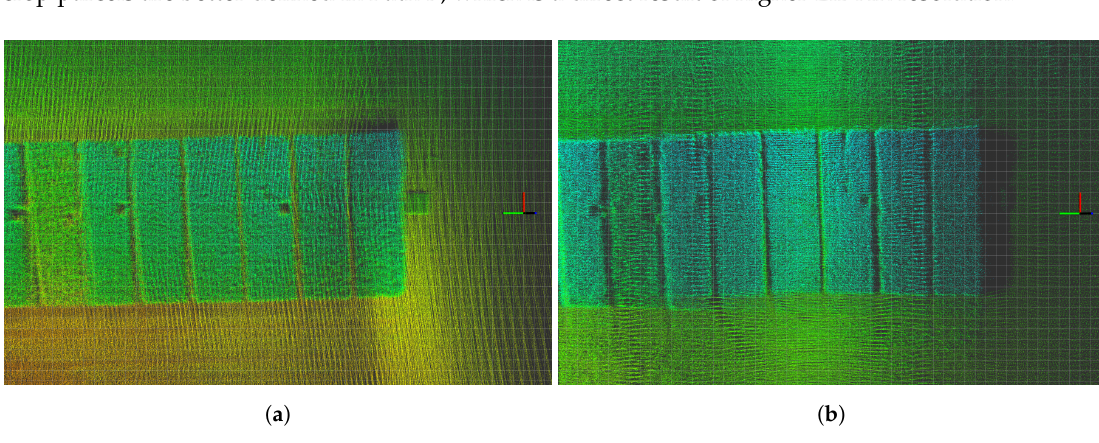
Figure 8. Raw LiDAR mapping data of flight paths over the experimental field illustrated by the ROS rviz 3D visualisation tool. Both are shown as relative coordinates from the take-off location of the UAV. The colour of individual points represents their z -axis value in the global frame. ( a ) mapping result of flight Path A, indicating a more homogeneous point cloud distribution; ( b ) mapping result of flight Path B, indicating a more heterogeneous point cloud distribution.